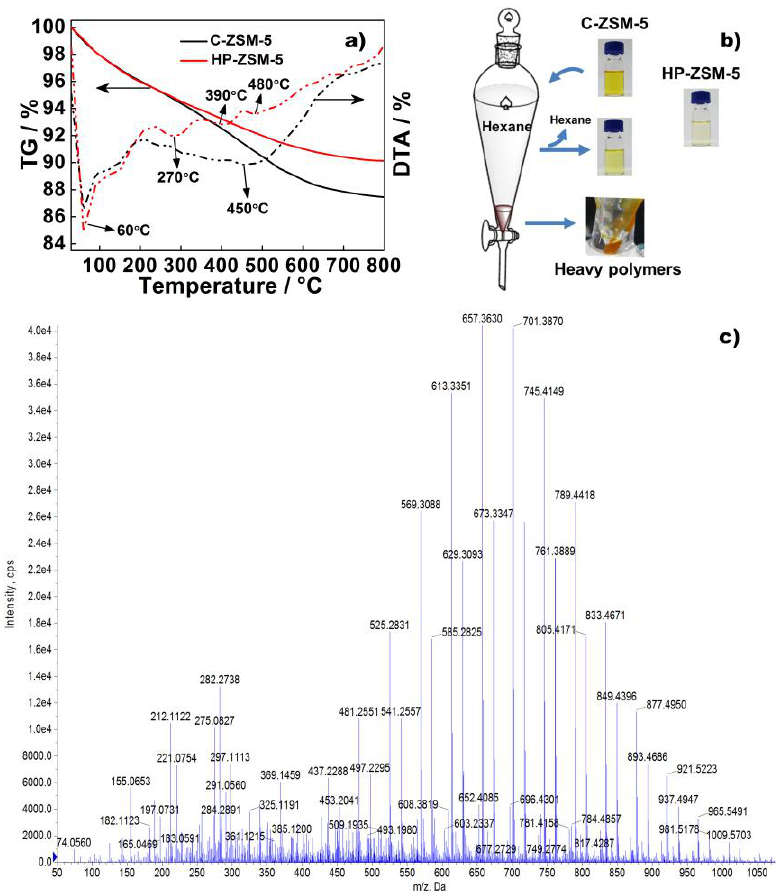
Figure 2. ( a ) Thermogravimetry-Differential Thermal Analysis (TG-DTA) curves of the spent C-ZSM-5 and HP-ZSM-5 under air atmosphere; ( b ) The separation of heavy polymers; ( c ) Time-of-Flight Mass Spectrometry (TOF-MS) spectrum of heavy